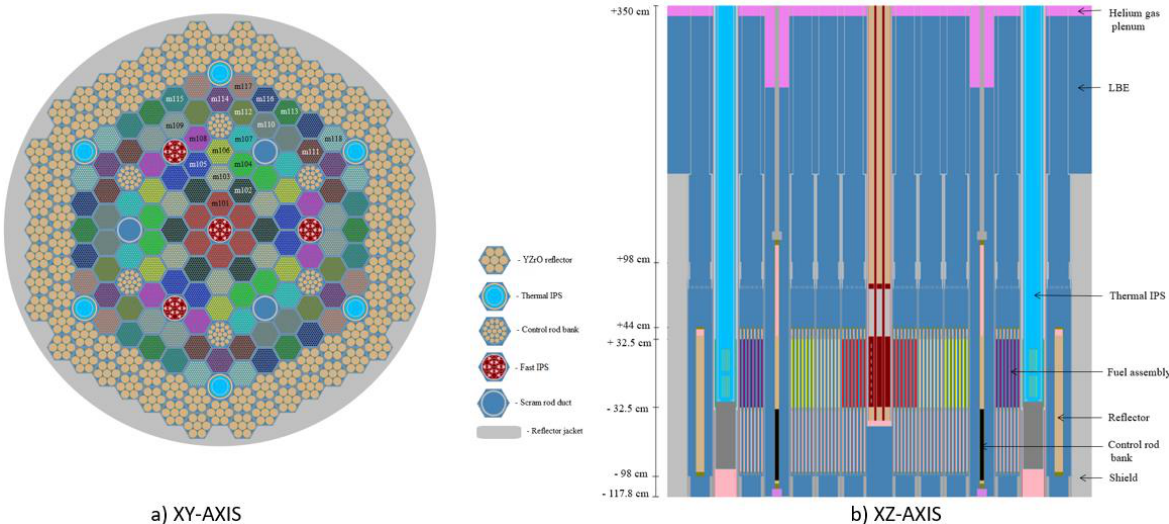
Figure 1. MYRRHA 1.6 based-model in